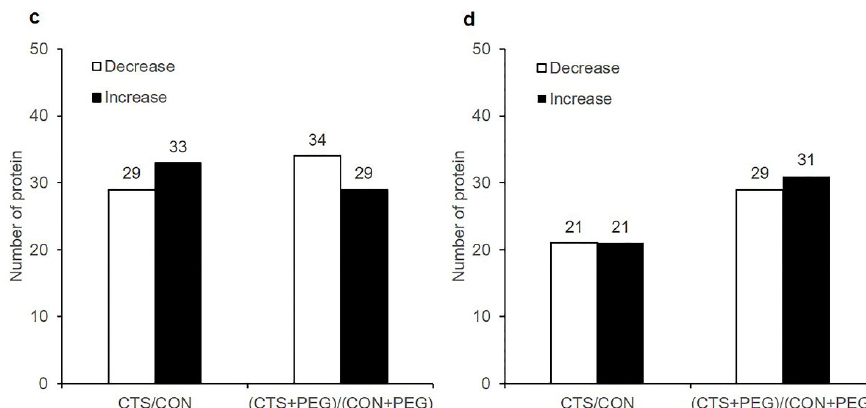
Figure 4. Heat map of significant DEPs of LPT123 ( a ) KDML105; ( b ) cultivars in the four treatment groups. The heat map was created using a MultiExperiment Viewer. Each row in the hierarchical clustering analysis represents an individual protein. The color scale (green to red) indicates low to high protein expression, and the numbers above the column refer to the number of replications. This shows the number of significant DEPs with and without CTS application in unstressed (CON and CTS) and stressed plants (CON + PEG and CTS + PEG) of LPT123; ( c ) and KDML105; ( d ) rice leaves.